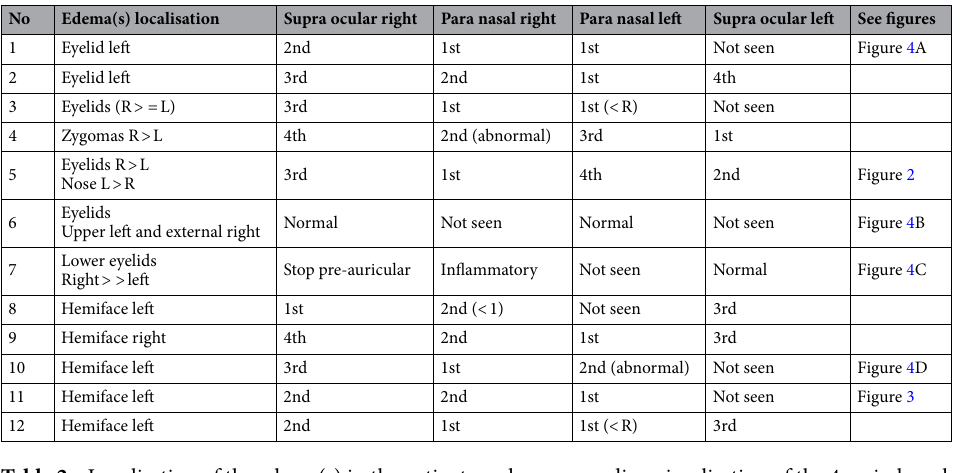
Table 2. Localisation of the edema(s) in the patients and corresponding visualisation of the 4 main lymphatic drainage pathways, either seen or not (with their order of appearance: 1st = first seen: 2nd = second drainage seen:…). No.